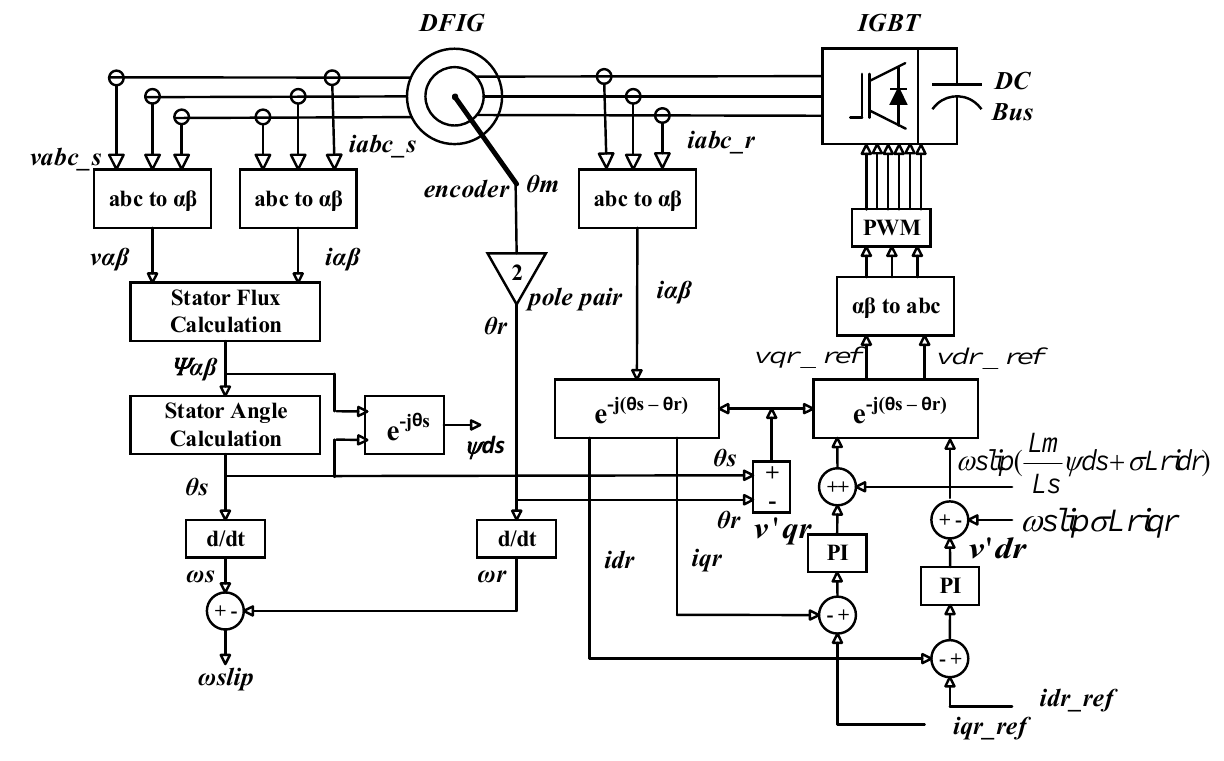
Figure 2. Control algorithm for the the DFIG-based